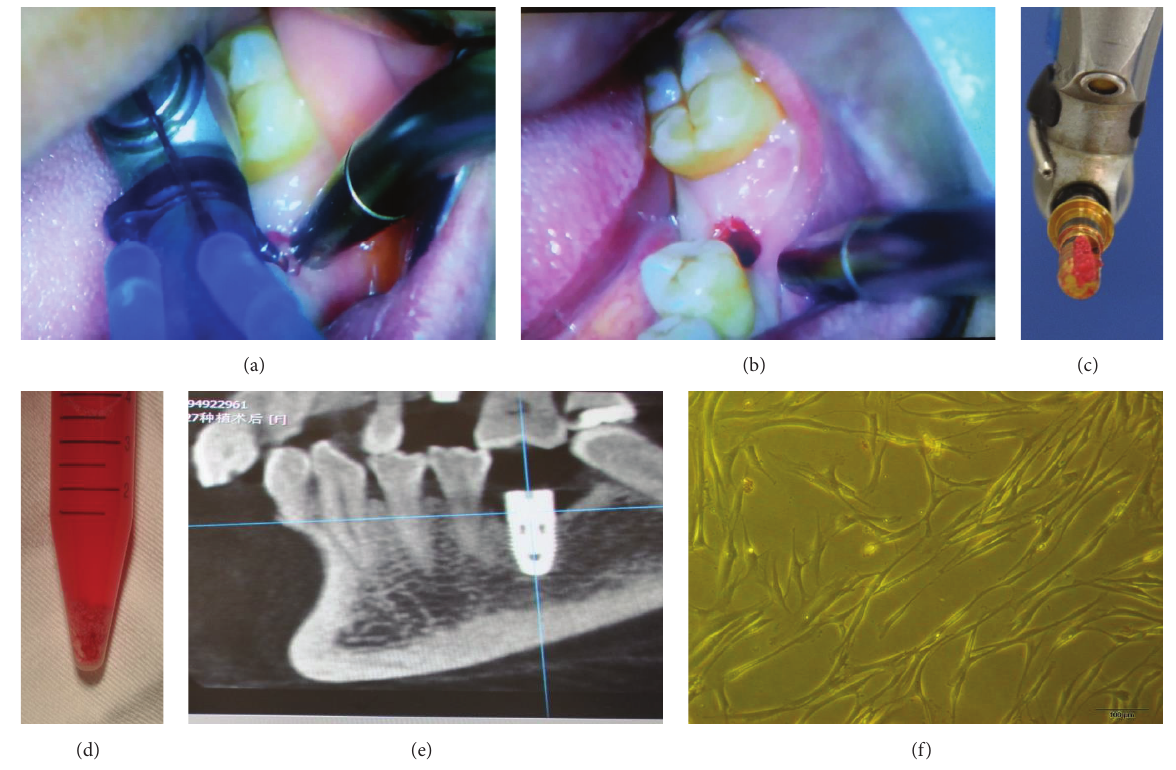
Figure 1: Clinical techniques for harvesting alveolar bone marrow. (a) The cancellous bone was drilled at 50 rpm until achieving the desired diameter and length for the implant site. (b) Before dental implant placement, bone marrow was harvested using a flapless, minimally invasive surgical procedure. (c, d) Bone marrow scraped from the pilot drill was immediately placed in sterile tubes and transported to the laboratory. (e) Confirmation of the initial stability of the dental implant by cone-beam CT. (f) Photomicrograph of aBMSCs 7–10 days following initial plating, revealing a fibroblastic, spindle shaped morphology similar to that of stem cells from other cell sources. Magnification: ×